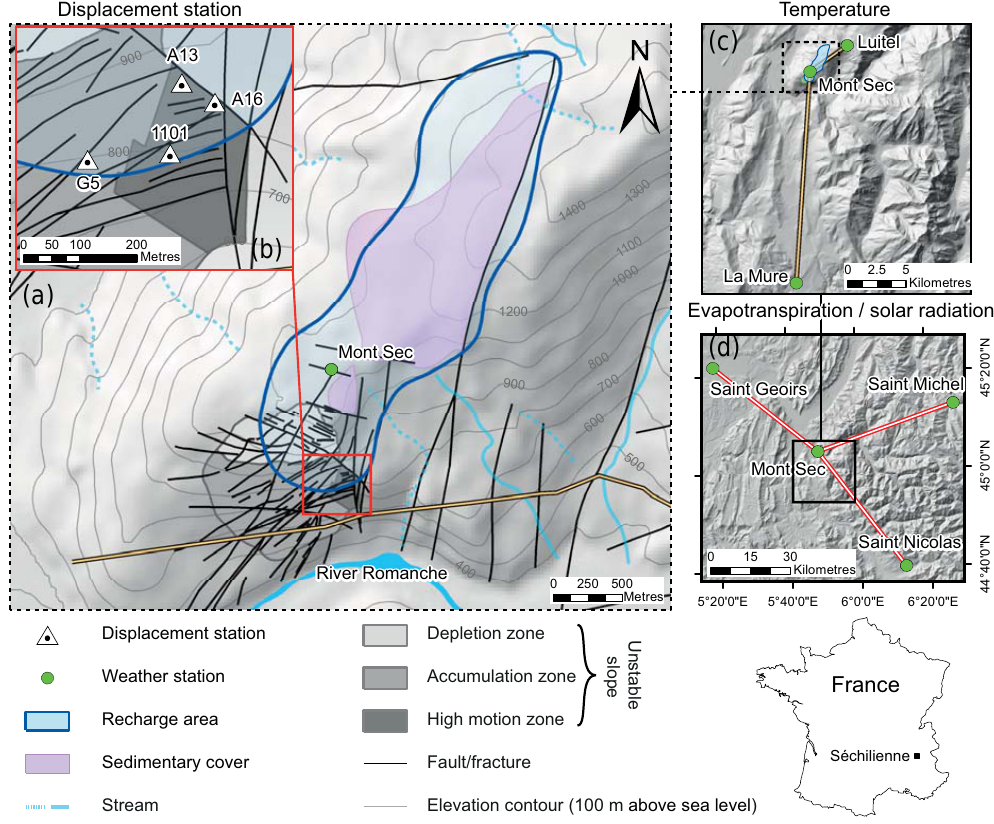
Figure 3. Location map of the Séchilienne landslide. (a) Map of the Séchilienne unstable slope and recharge area with the Mont Sec weather station. (b) Enlarged map of the most active area showing displacement stations. (c) Map showing the weather stations used for the temperature estimation at Mont Sec. (d) Map showing the weather stations used for evapotranspiration and solar radiation method